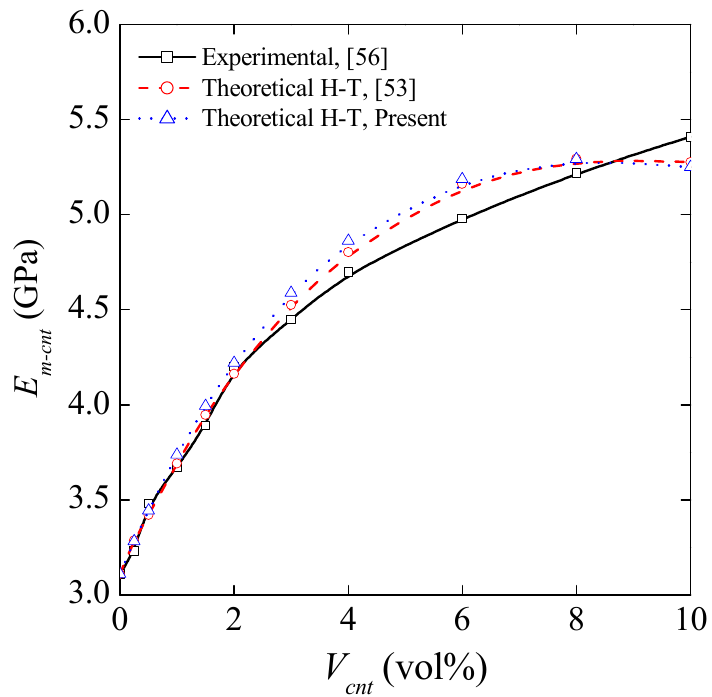
Figure 6. Young’s modulus of CNT-reinforced matrix as a function of V cnt (vol%). The diagram shows the effect of MWCNT inclusion on Young’s modulus of the matrix by changing the volume fraction. To ensure the validity of the process, identical material properties were employed.